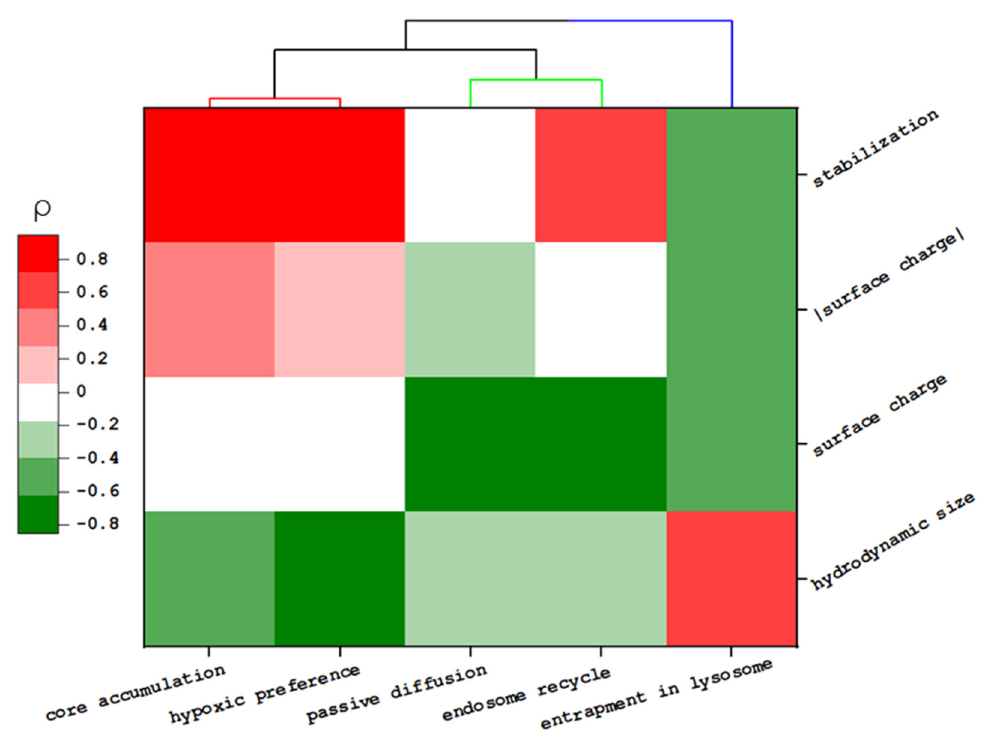
Figure 4. Heat map of the relationship between the physicochemical properties of MSNs and their transportation behavior. The color map represents the Spearmen coefficient value ( ρ ).